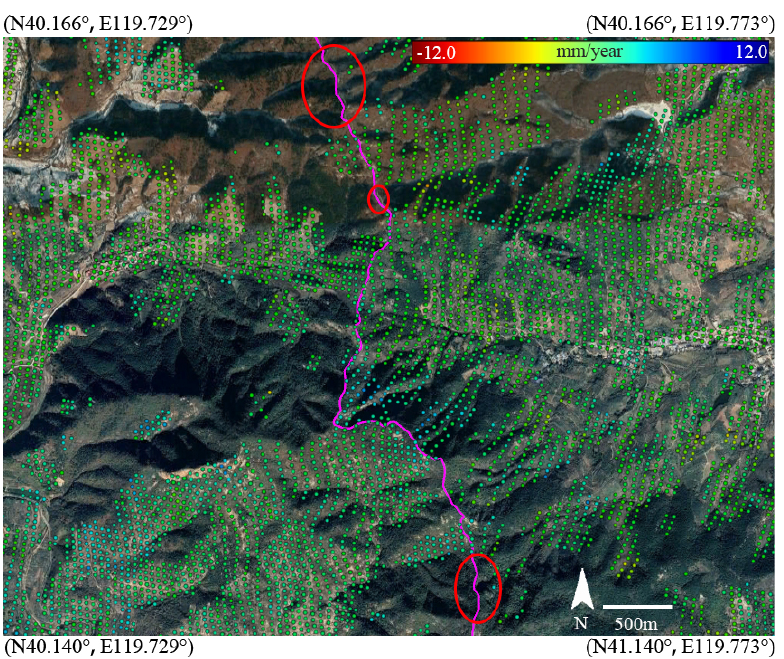
Figure 17. Distribution of InSAR measurements; red circles indicate areas with gaps in the InSAR measurements along the Great Wall. The purple line indicates the location of the Great Wall.